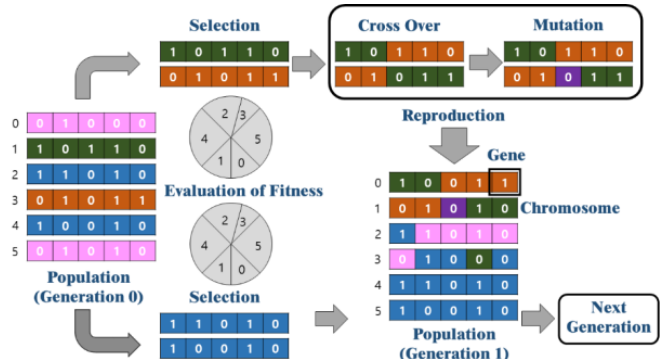
Figure 3. Genetic selection method using genetic algorithm.